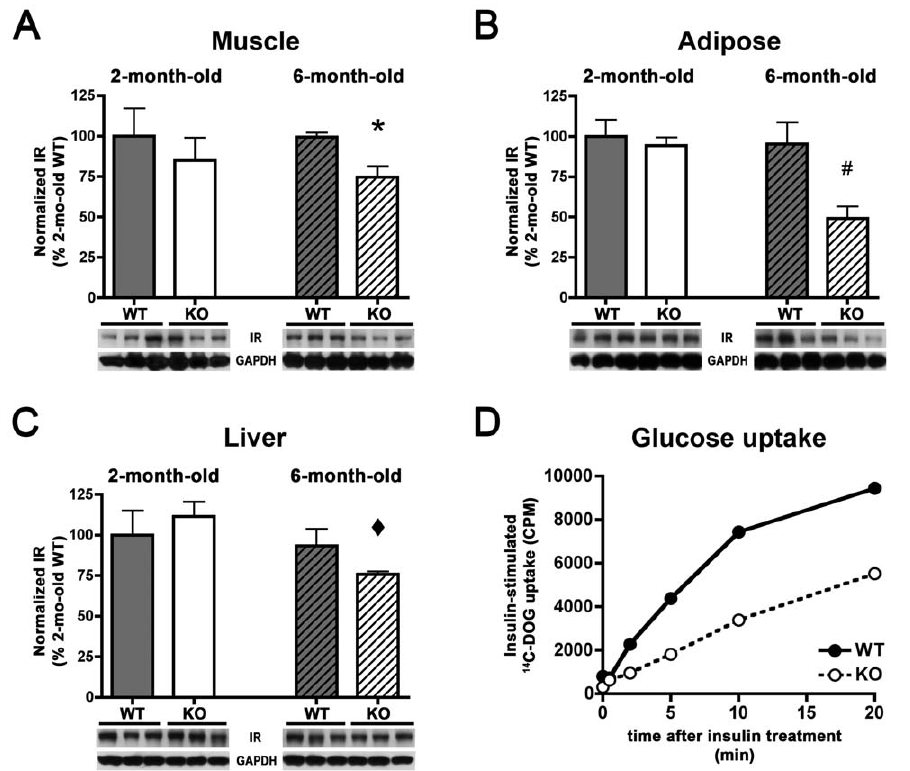
Figure 4. IDE-KO mice show age-dependent reductions in IR levels and insulin-stimulated glucose uptake that correlate with the onset of the diabetic phenotype. A – C , IR levels in muscle ( A ) adipose ( B ) and liver ( C ) tissue from wild-type (WT) and IDE-KO (KO) mice. Note that IR levels in IDE-KO mice are significantly decreased in all tissues at 6 months, but not at 2 months of age. Graphs show mean 6 SEM of IR levels quantified by luminescent imaging (see Materials and Methods ) and normalized to IR levels in 2-mo-old WT mice. *P , 0.05 relative to 6-mo-old WT mice; # P , 0.01 relative to 2-mo-old KO mice and P , 0.05 relative to 6-mo-old WT and KO mice; X P , 0.05 relative to 2-mo-old KO mice, all determined by 2-tailed Student’s t tests. D , Insulin-stimulated glucose uptake is significantly impaired in primary adipocytes isolated from 6-mo-old IDE-KO mice. Quantification was performed by measuring cellular uptake of 14 C-deoxyglucose ( 14 C-DOG) various times after addition of insulin (16.7 nM). Data are mean of 2 independent experiments utilizing epididymal adipose tissue collected from 4 mice per condition for each